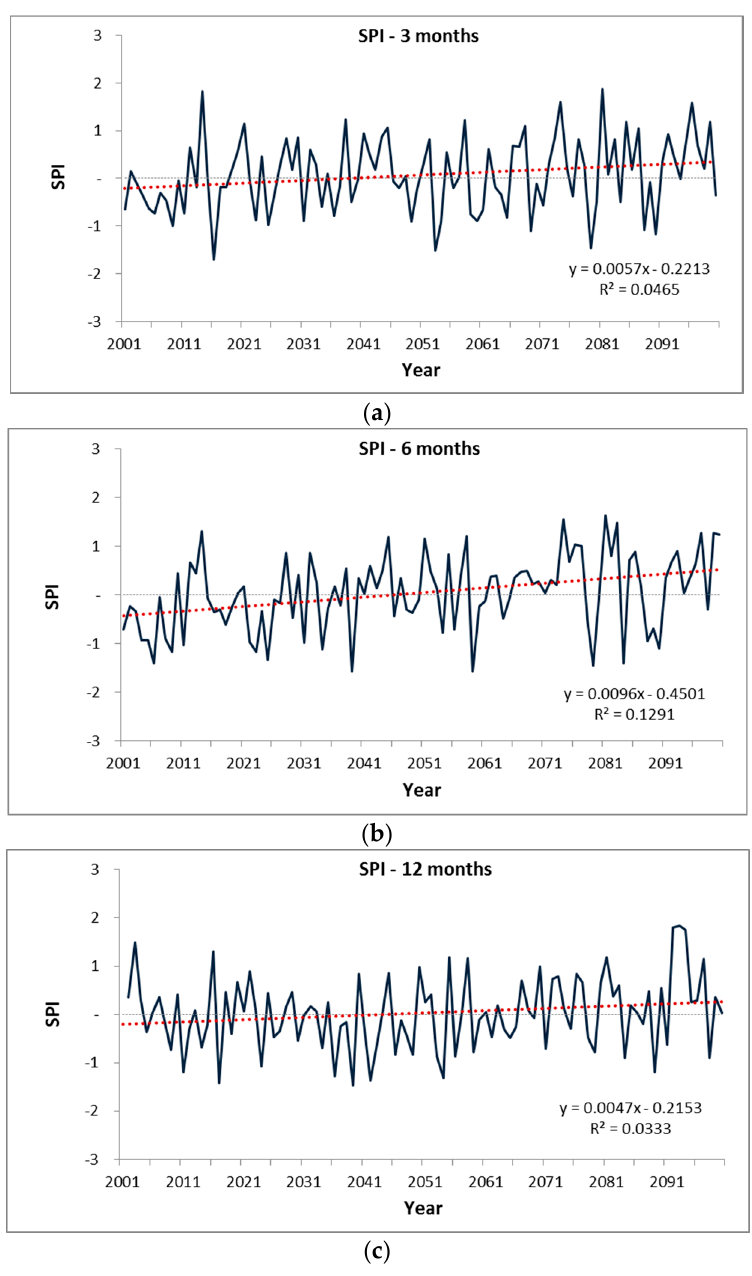
Figure 4. SPI estimation results for three selected periods in Korea: ( a ) Period of 3 months; ( b ) Period of 6 months; ( c ) Period of 12 months.